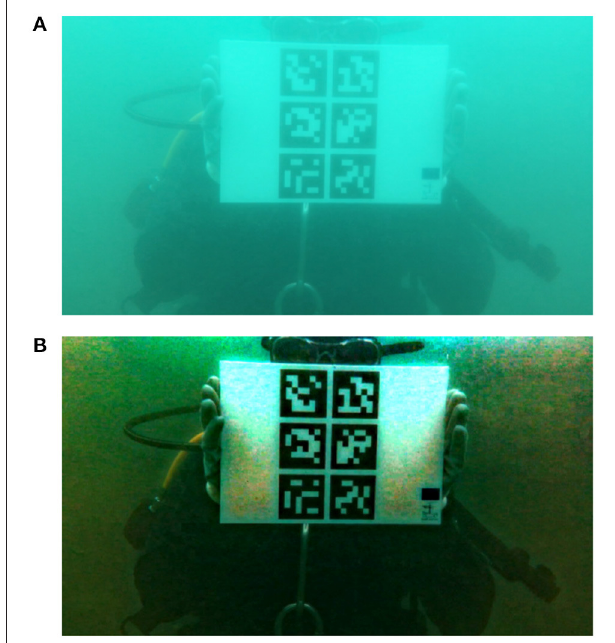
FIGURE 4 | Underwater image showing markers (A) processed by the BCP method (B) . Subject provided written informed consent for publication of this